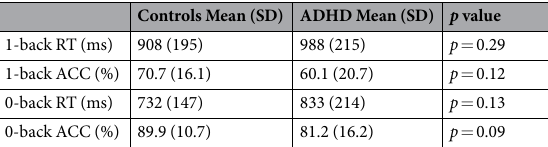
Table 1. Behavioral